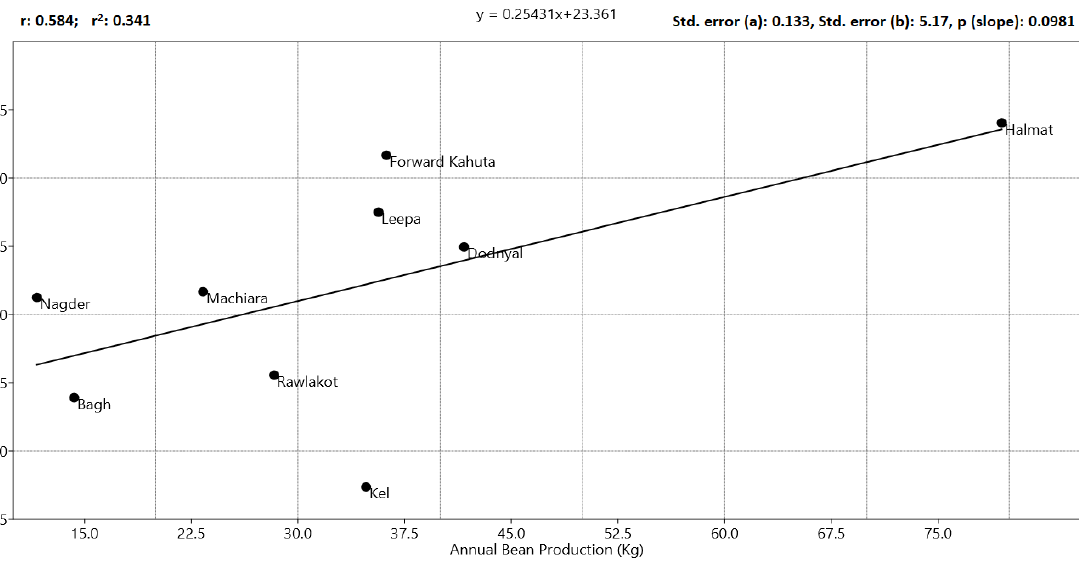
Figure 3. Generalized linear model regression plot of common bean production vs consumption patterns in the AJK region.